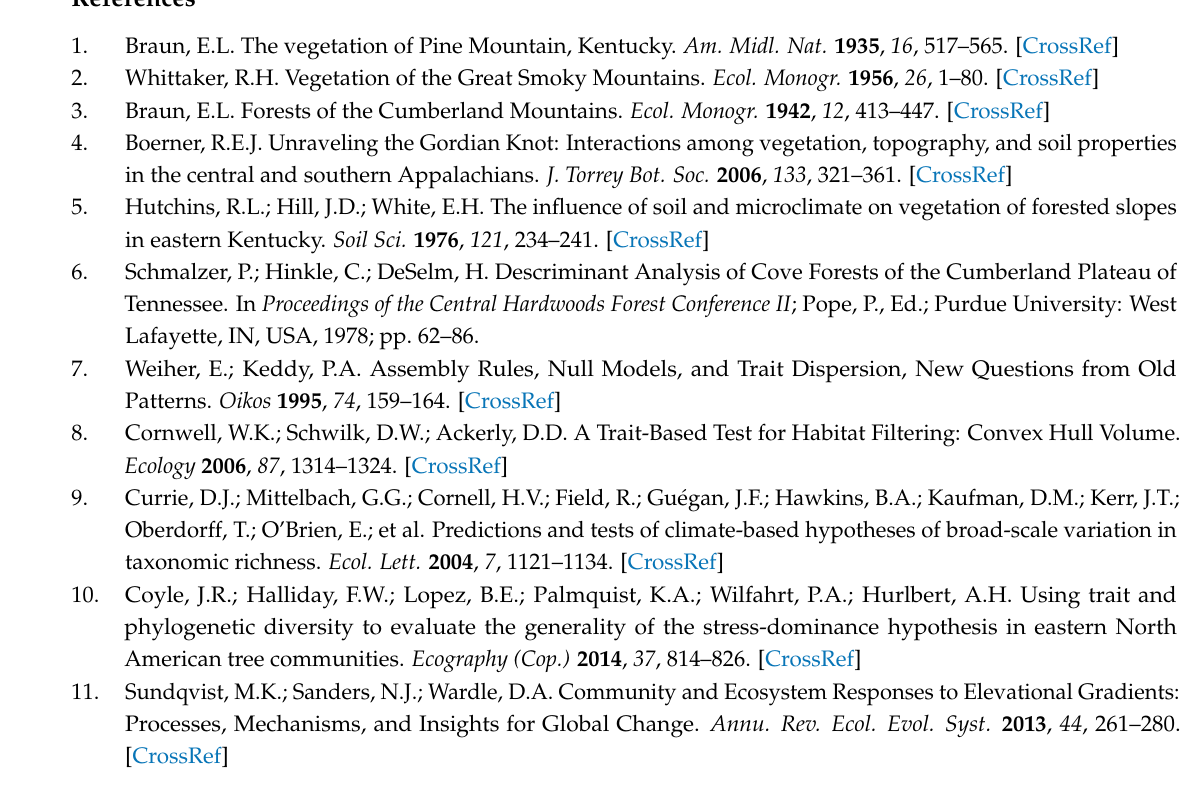
Table S1: Axis loadings and explained variance from principle components analysis of soil variables, Figure S1: Biplots showing plot scores (points) and soil variable scores (arrows) for the first four axes of the principle components